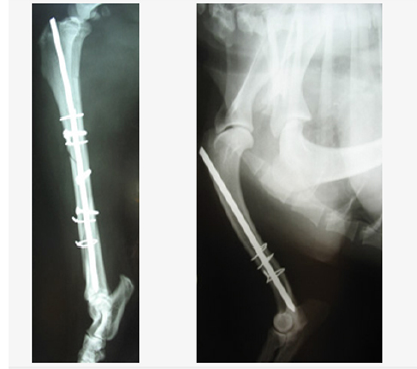
Figure 3 – Osteosynthesis of the tibia (shin) with the intramedullary nail, tightening screws and orthopedic wire (left), or osteosynthesis of the humerus (upper arm) with the intramedullary nail and orthopedic wire